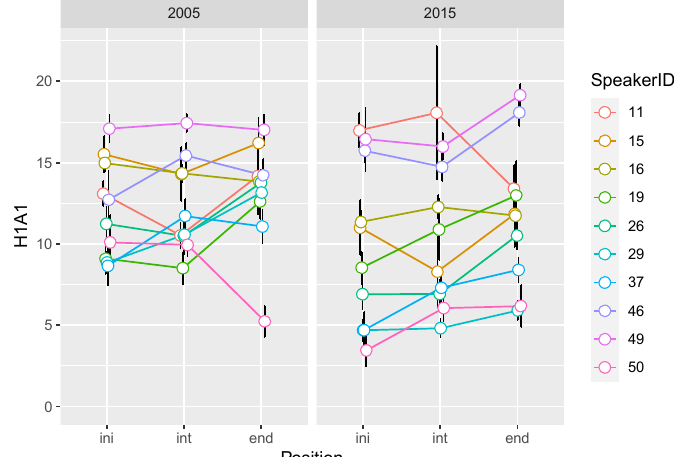
Figure A3. Speaker-specific data for f0 .